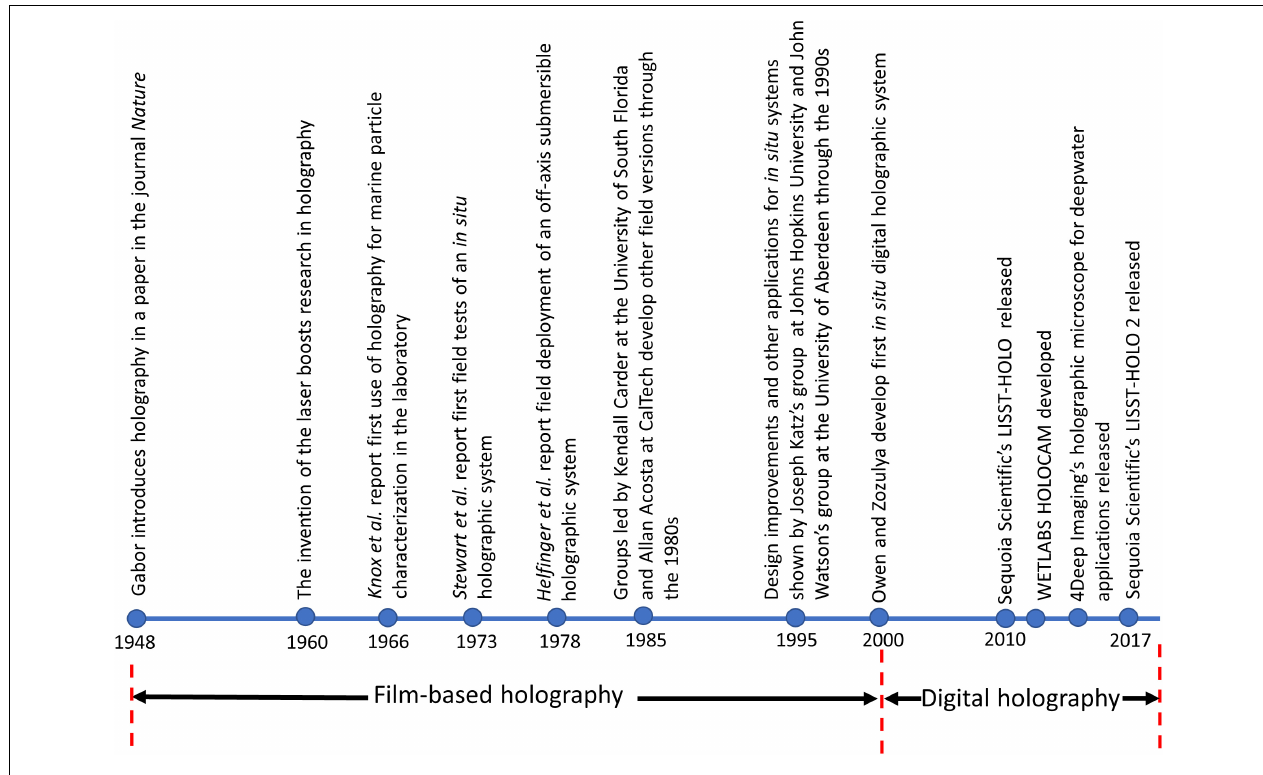
FIGURE 1 | A timeline of the historical developments in holography in the context of in situ aquatic applications. TABLE 1 | Sampling characteristics of selected free-stream, digital holographic imaging systems reported in literature since 2000. Digital holographic imaging